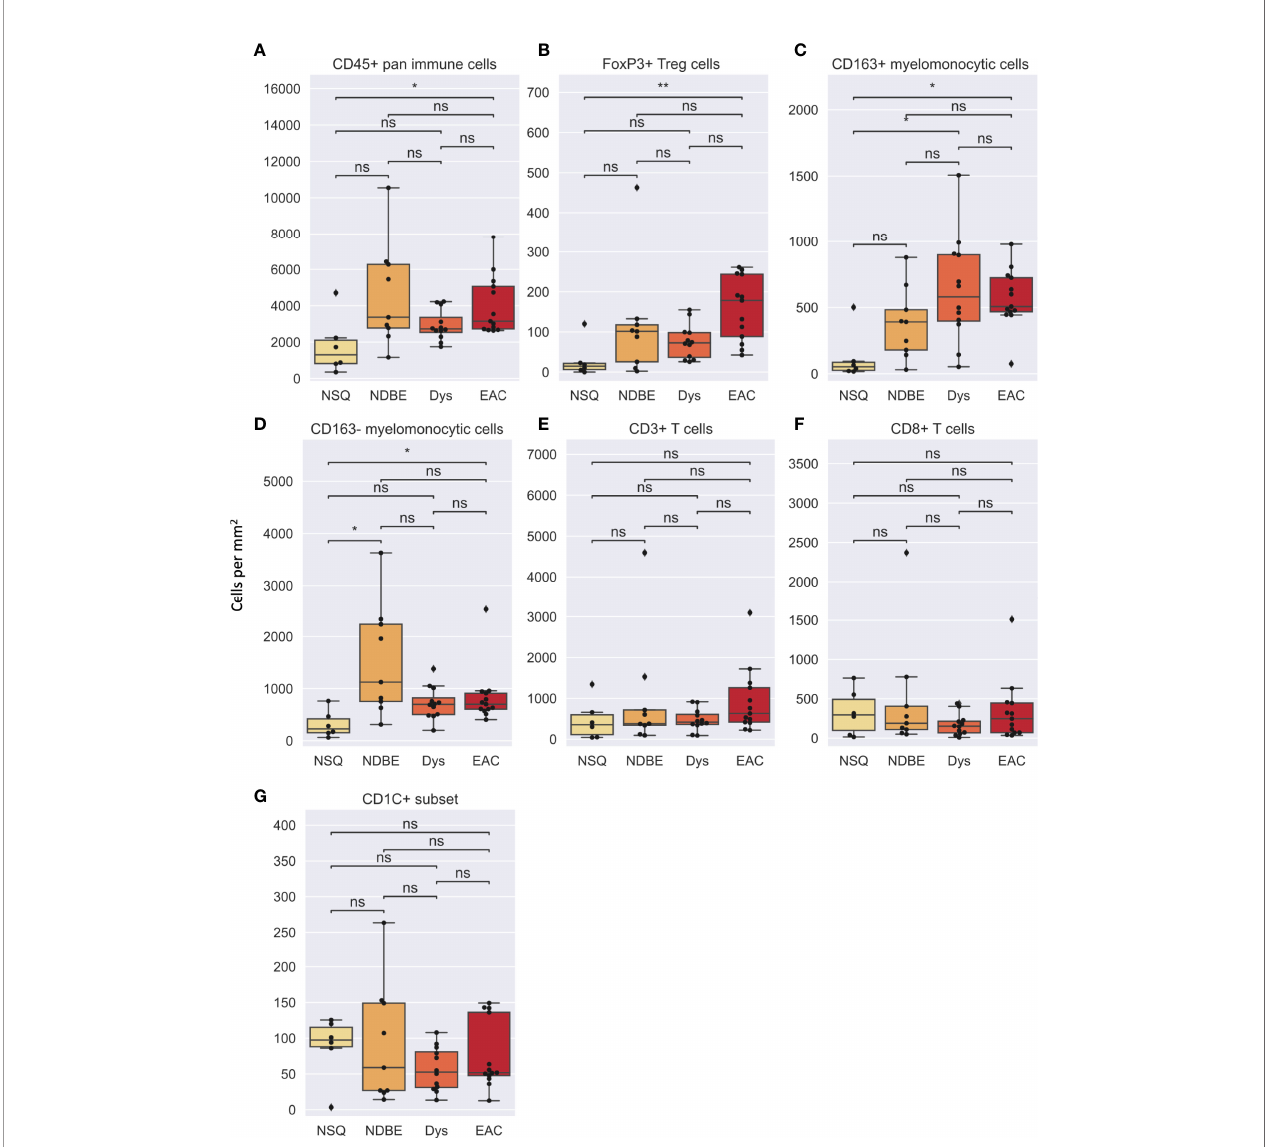
FIGURE 4 | Cell density per mm 2 of various gated cell subsets based on Image Cytometry at different disease stage. (A) CD45 + pan immune cells, (B) FoxP3 + Treg cells, (C) CD163 + myelomonocytic cells, (D) CD163 – myelomonocytic cells, (E) CD3 + T cells, (F) CD8 + T cells and (G) CD1C + subset. Statistics: Mann-Whitney- Wilcoxon test two-sided with Bonferroni correction: ns (not signi fi cant): p > 0.05; *p ≤ 0.05; **p ≤